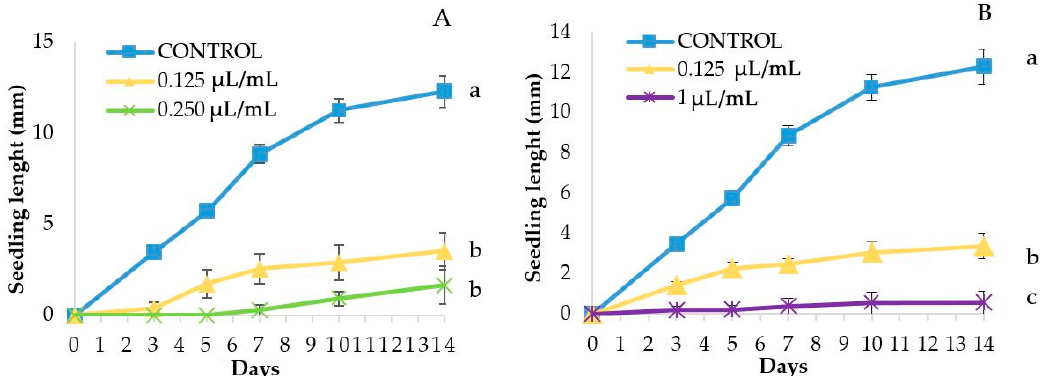
Figure 1. Seedling length (mm) (mean ± SE) in Portulaca oleracea control or treated with TC1 ( A ) and TC2 ( B ). Different letters at the end of the growth curves indicate significant differences among doses ( p < 0.05) using Fisher’s least significant difference (LSD) test. Molecules 2019 , 24 , x FOR PEER REVIEW